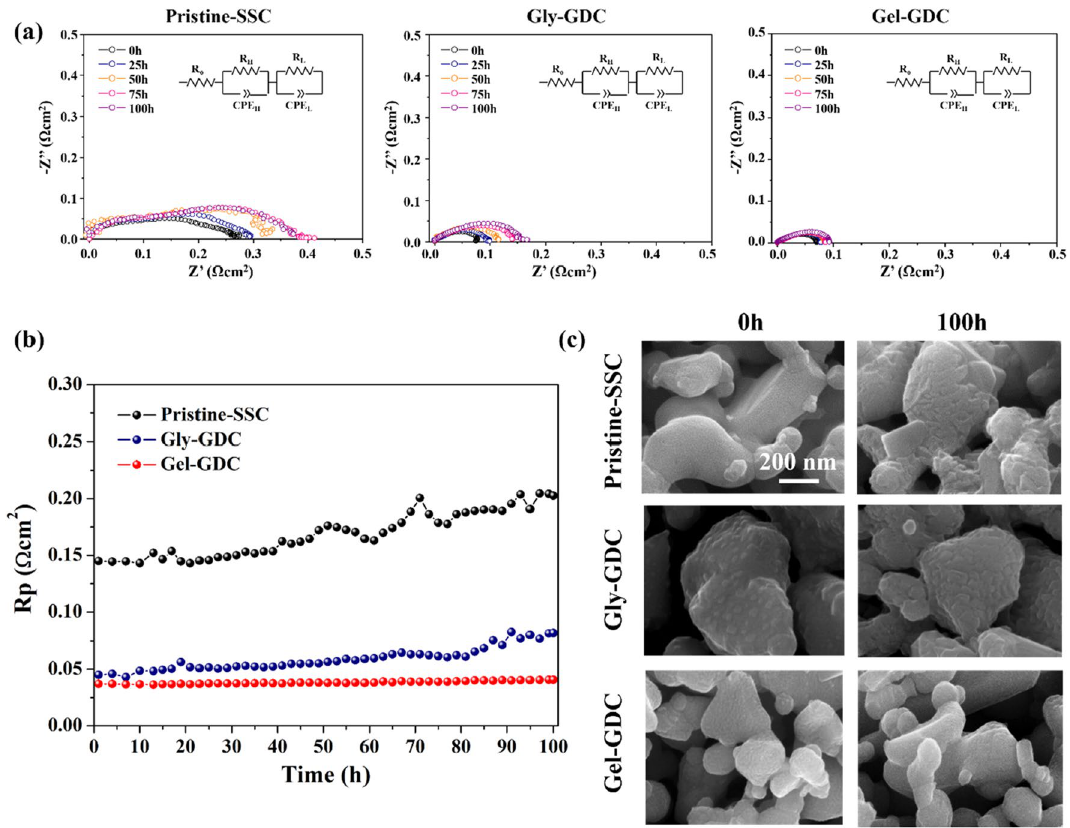
Figure 5. Stability test for 100 h at 650 °C. ( a ) Nyquist plots of Pristine-SSC, Gly–GDC, and Gel–GDC for long-term operation, ( b ) Variation of R p s for long-term operation, and (c) SEM images of the SSC with different coatings at 0 h and 100